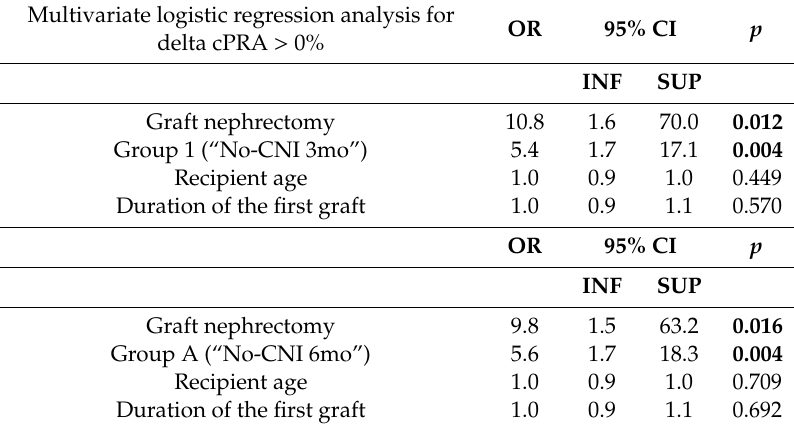
Table 6. Results of the multivariate logistic regression analysis for delta cPRA > 0%. The bold: p values less than 0.05 defined statistical significance Multivariate logistic regression analysis for delta cPRA > 0%